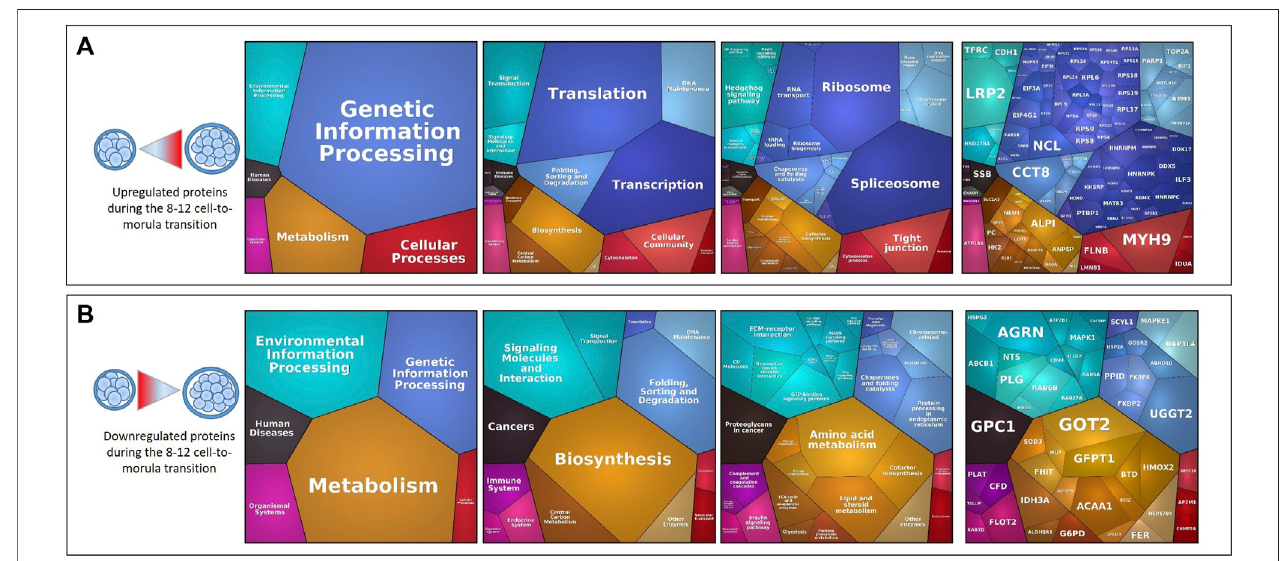
FIGURE 6 | Proteomaps of differentially abundant proteins (DAPs) during the 8 – 12 cell-to-morula transition. Proteomaps were carried out using the lists of gene names of proteins increasing [ (A) , upper panels] or decreasing [ (B) , down panels] in abundance (t-test p-value ≤ 0.05; min fold-change of 2) between the 8 – 12 cell and morula stages and based on the KEGG Pathway gene classi fi cation. Functional categories (left and middle panels) and related proteins (right panel) are shown by polygons. Areas of polygons illustrate protein abundance, weighted by protein size. Functionally related functions/proteins are arranged in common regions and coded using similar colors.